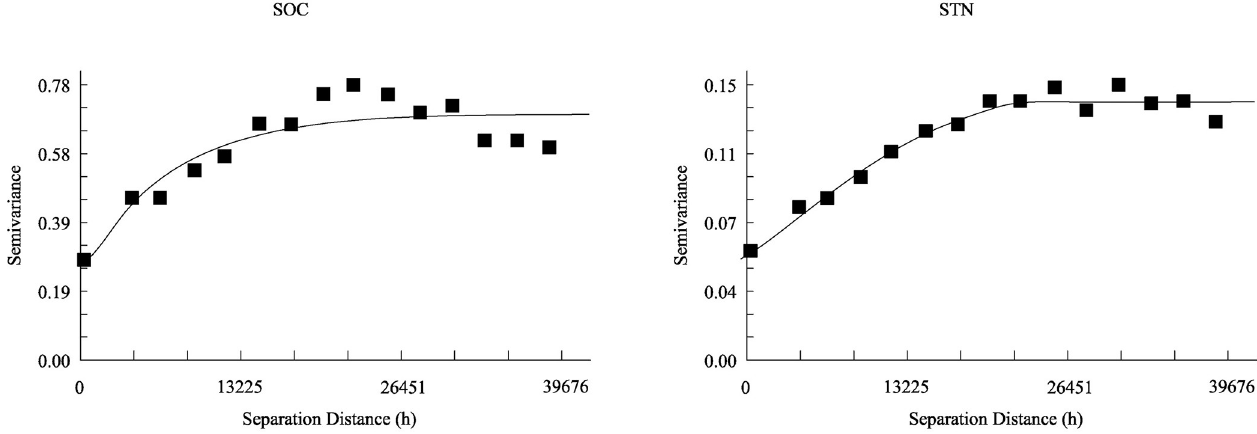
Fig 3. Semivariogram (dots) and fitted models (lines) of SOC and